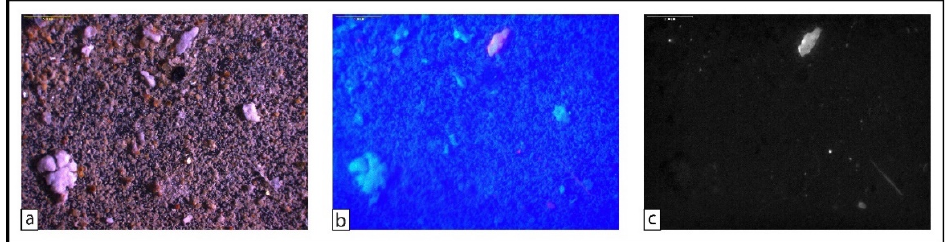
Figure 6. High-magnification image of an analyzed filter membrane. ( a ) Original image under normal light; the white object in the bottom-left corner is supposed to be K 2 CO 3 precipitate. ( b ) Same filter portion under fluorescence conditions. ( c ) The final output from ImageJ (red